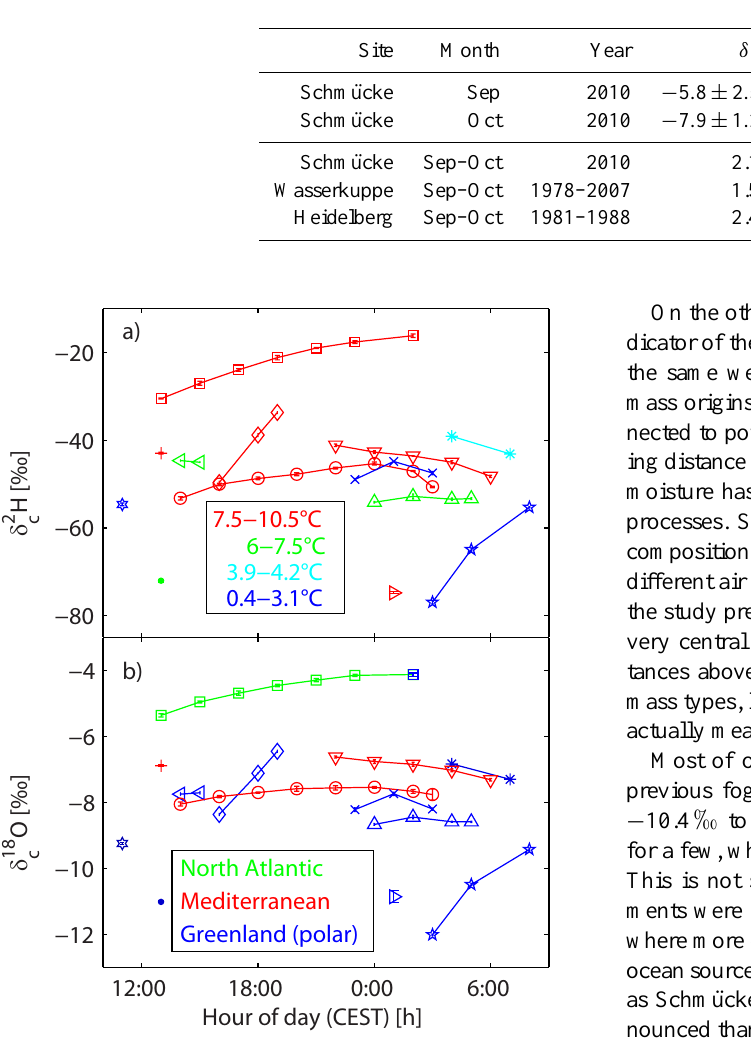
Table 2. Volume weighted monthly mean values for September and October for the collected cloud water samples at Schm¨ucke (first part). Second part: Differences between the volume weighted mean values for September and October ( δ (September) minus δ (October)) for the Schm¨ucke cloud samples. For comparison differences between volume weighted monthly mean values in precipitation for the closest GNIP collected in Heidelberg by Jacob and Sonntag (1991) are also given. See Fig. 1 for details on the sites.